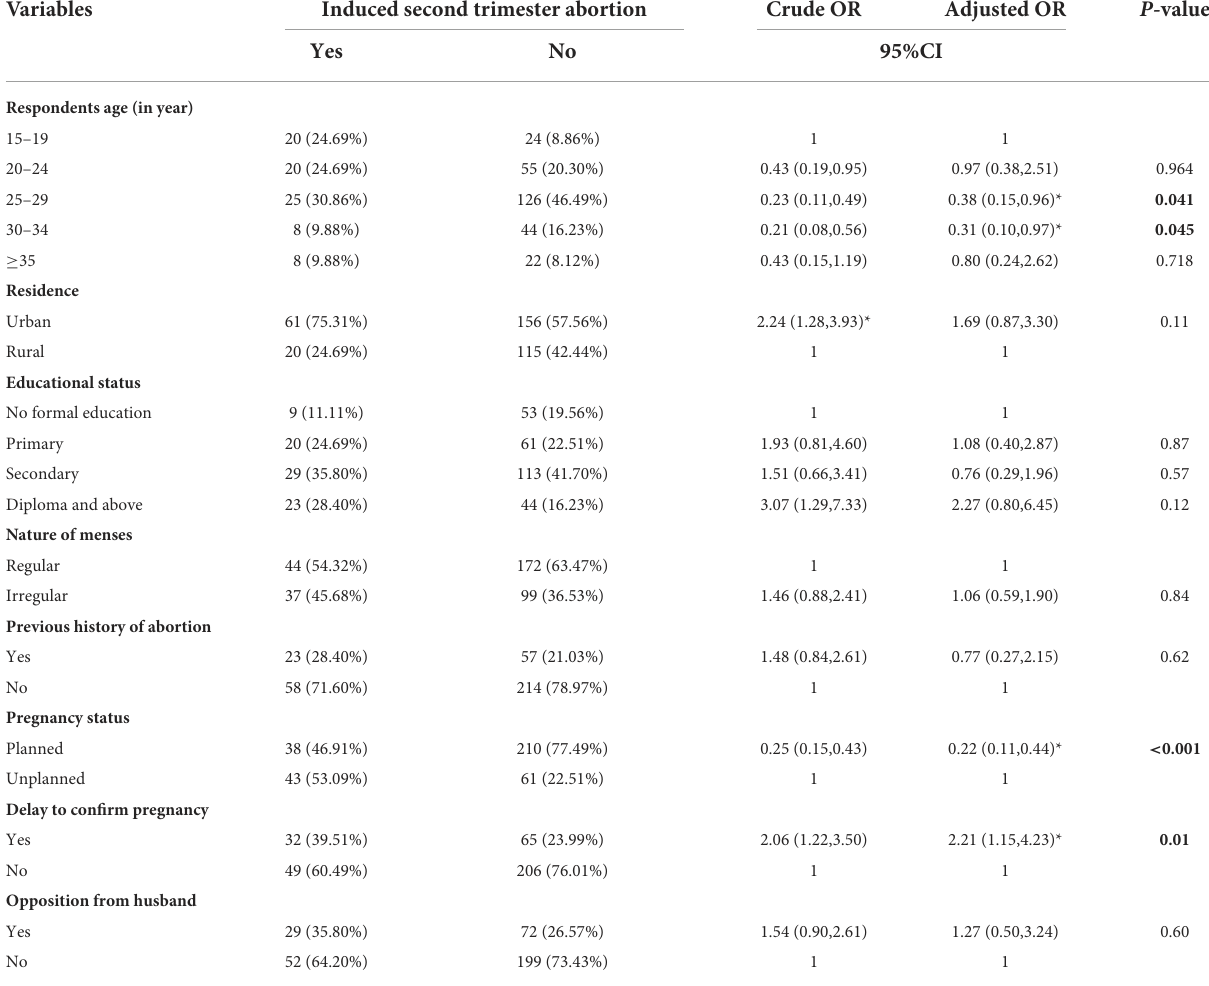
TABLE 4 Bivariate and multivariable analysis of women who received abortion care services in public hospitals of Arba Minch and Wolayita Sodo towns, southern Ethiopia,